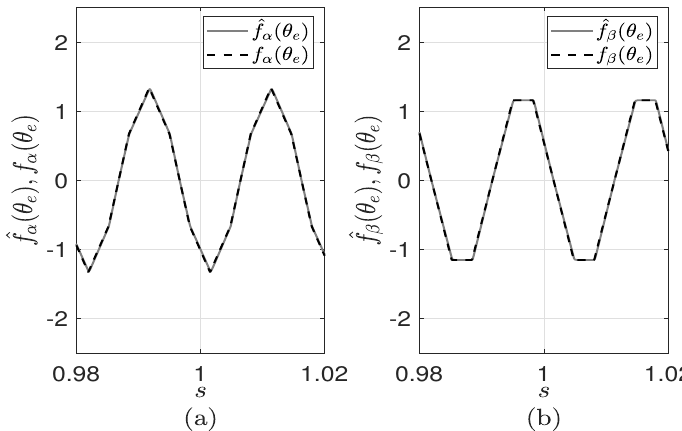
Figure 7. ( a ) Sliding mode based observer back-EMF function f α estimation; ( b ) Sliding mode based observer back-EMF function f β estimation.